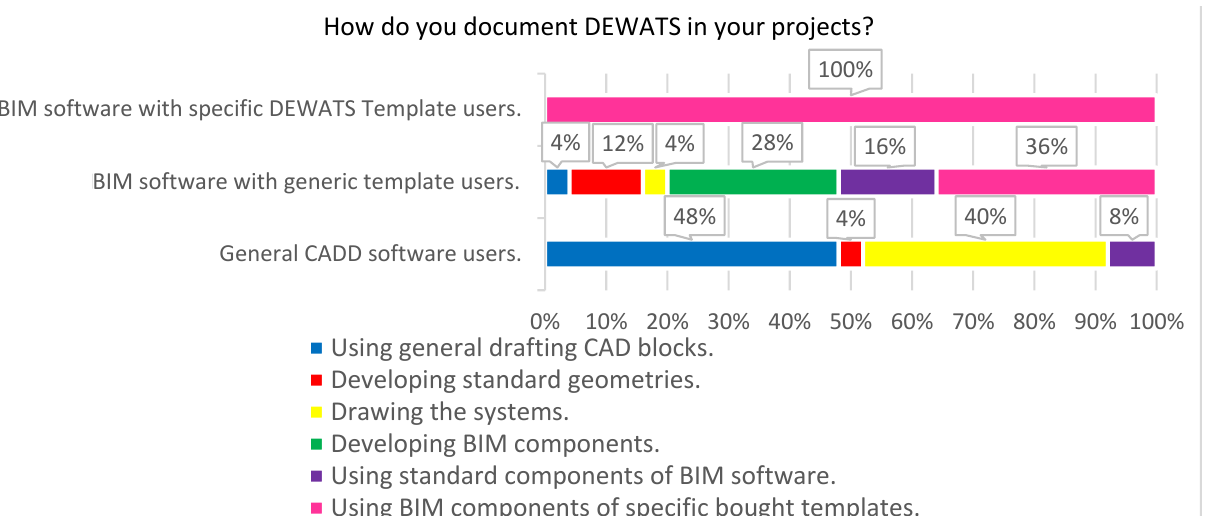
Figure 6. Answers to the fourth question. Source: authors (2020).